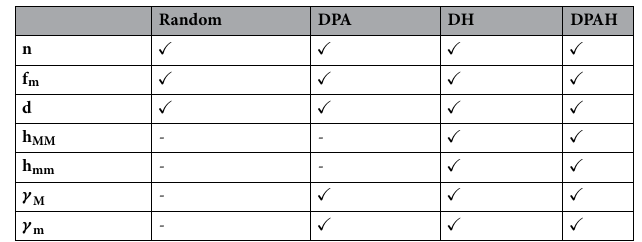
Table 2 . Model parameters. Check marks denote that a given model (column) requires a particular parameter (row): number of nodes n , fraction of minorities f m , edge density d , in-class homophily h aa , and the power- law exponent of the activity distribution γ . Sub-indices M and m refer to the majority and minority groups, respectively. The difference between DH and DPAH is the preferential attachment (in-degree) mechanism. All models produce directed networks.